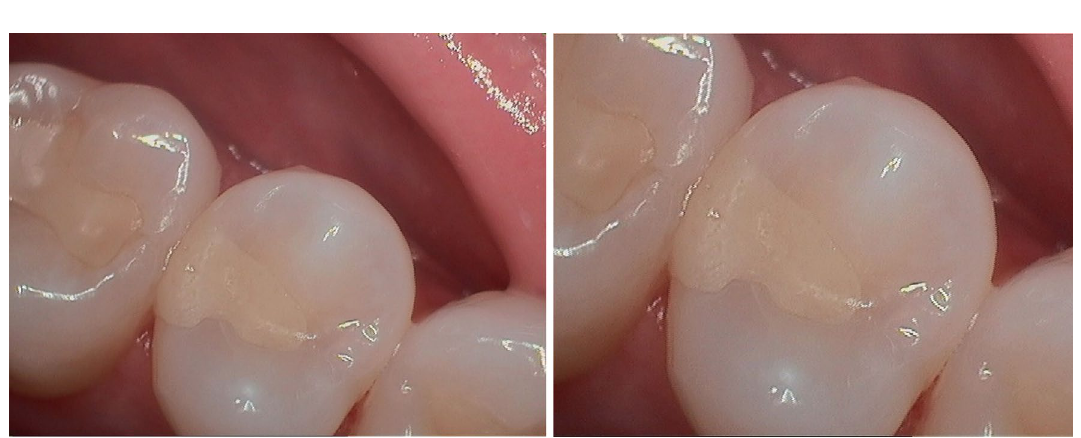
Figure 3. Class II restoration in second upper premolar at 1-year recall (left) with no visible sign of surface roughness